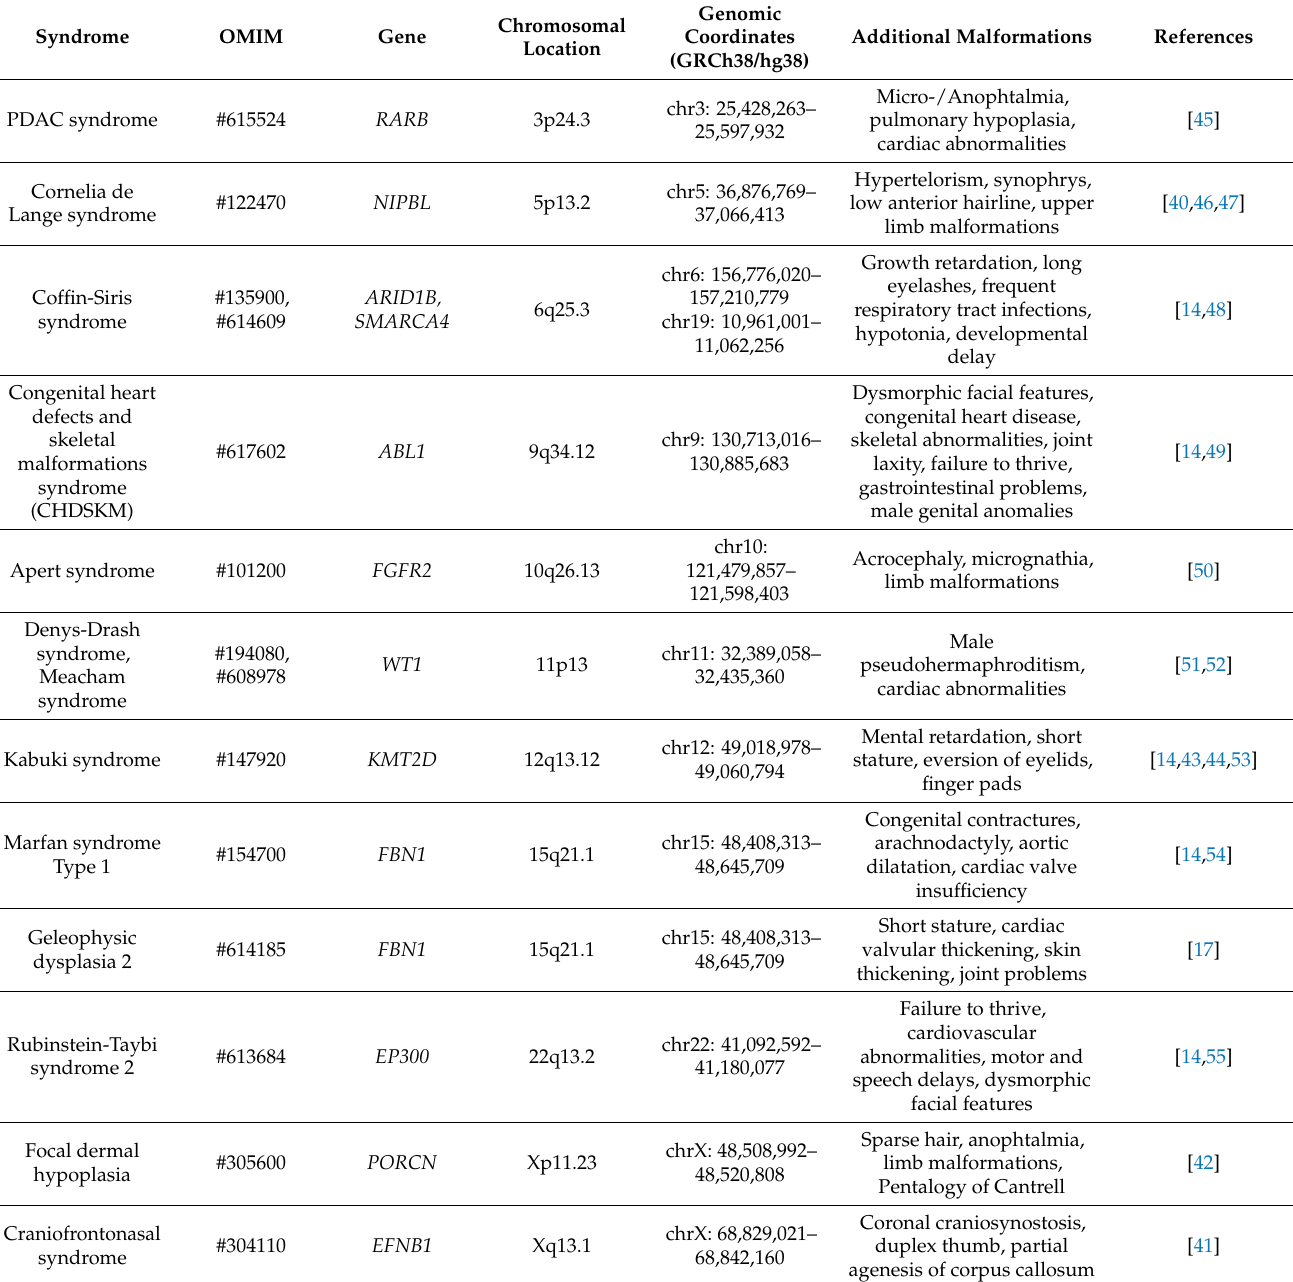
Table 1. Monogenic syndromes with associated CDH caused by de novo